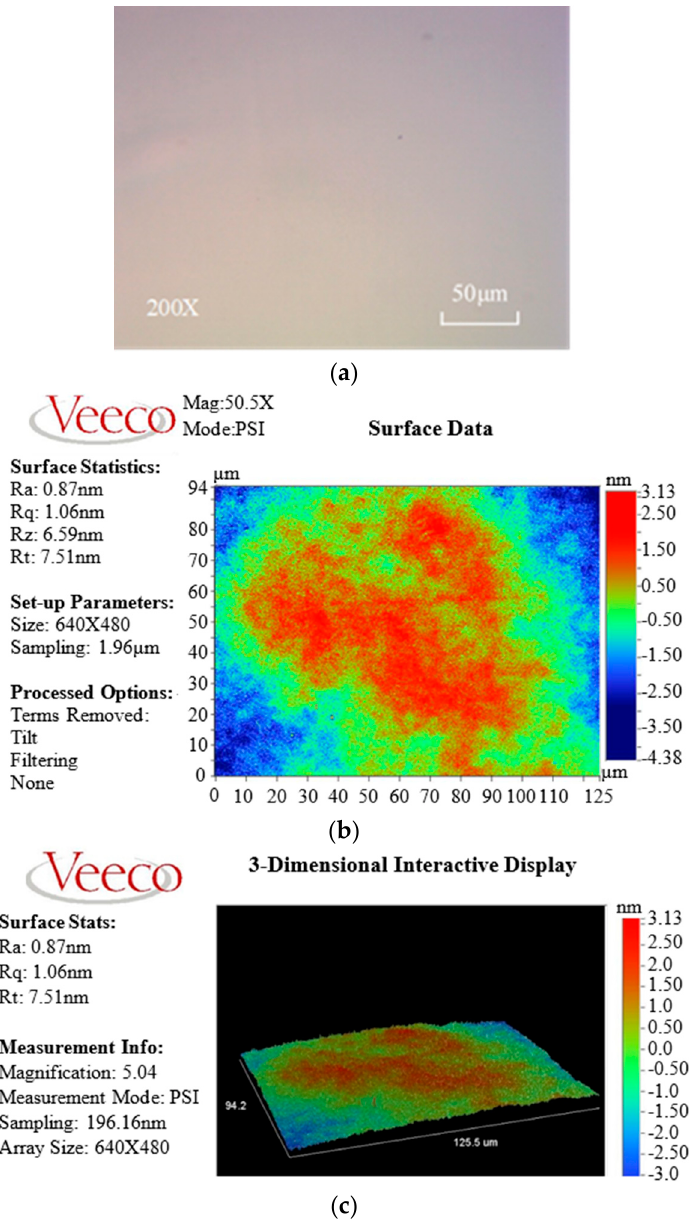
Figure 17. Final state of the sapphire substrate: ( a ) surface micrograph; ( b ) 2D surface morphology; and ( c ) 3D surface morphology.